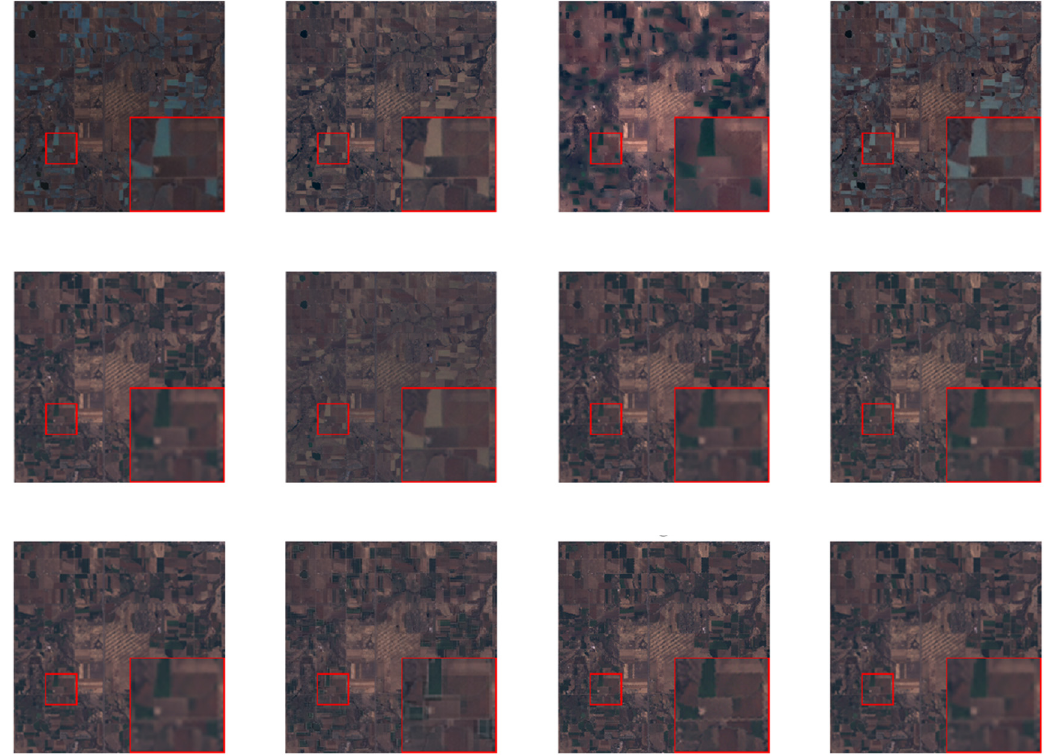
Figure 9. The first group of visualization results.